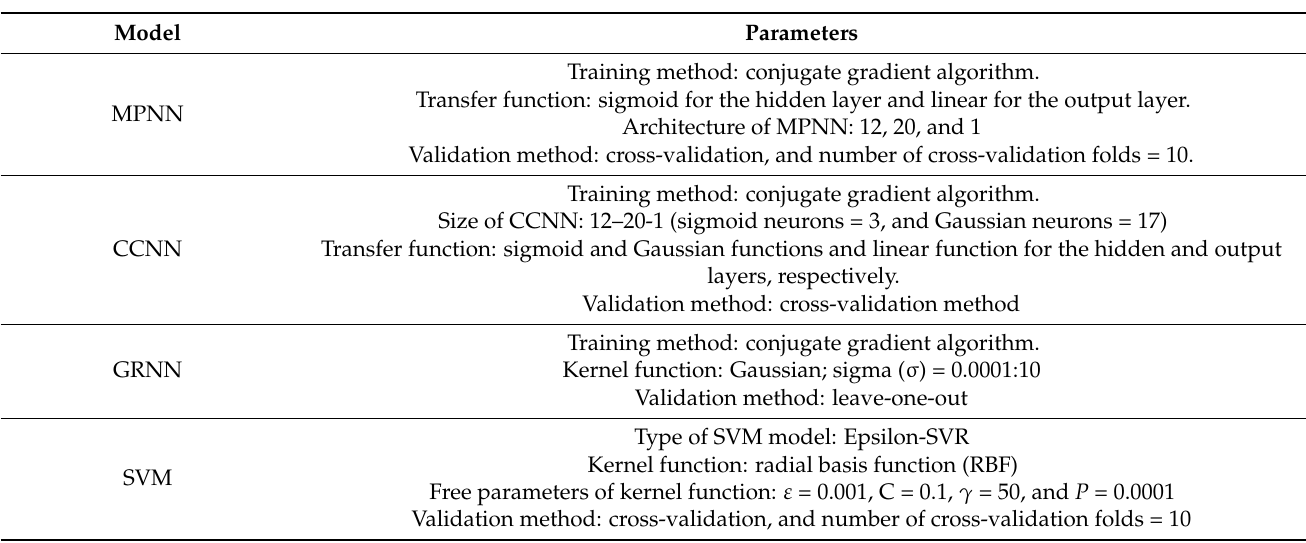
Table 4. Model parameters of the ANN and SVM